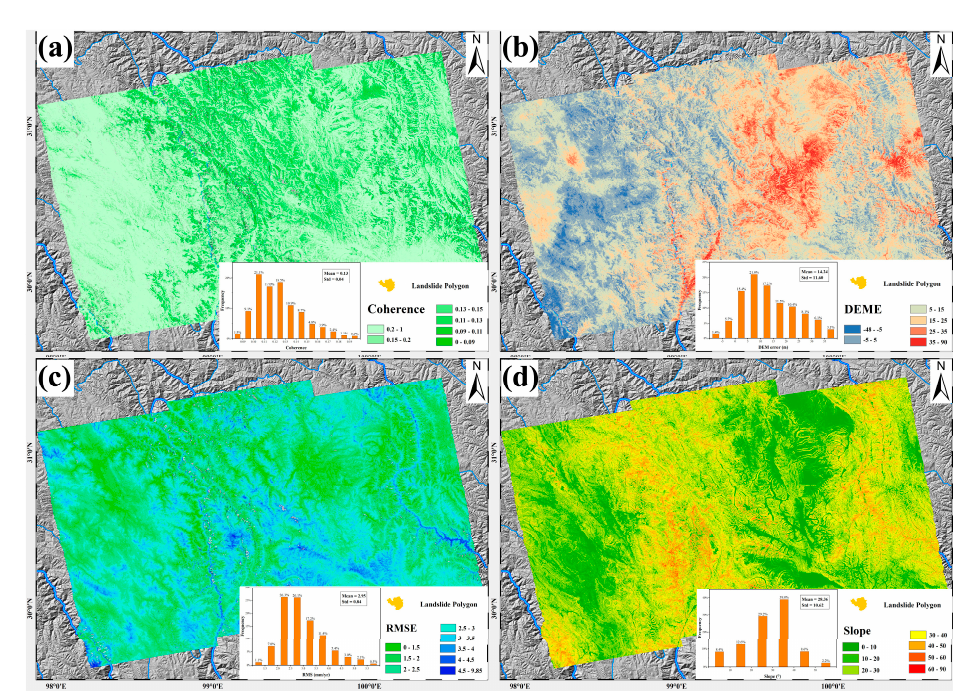
Figure 14. Landslide polygon statistics. ( a ) γ mean with its landslide polygons statistic. ( b ) DEME with its landslide polygons statistic. ( c ) RMSE with its landslide polygons statistic. ( d ) Slope with its landslide polygons statistic.